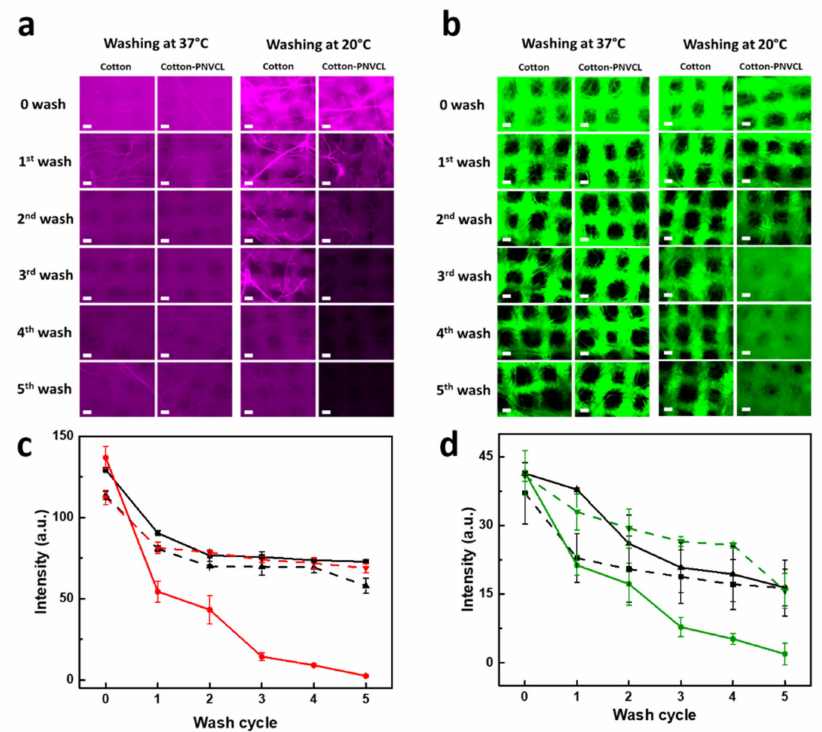
Figure 6. Fluorescence micrographs of ( a ) streptavidin-Cy5 and ( b ) green fluorescent protein (GFP) immobilized on cotton and cotton-PNVCL, recorded after washing 0, 1, 2, 3, 4, and 5 times at 37 and 20 ◦ C; scale bars: 100 µ m. ( c , d ) Fluorescence intensities of ( c ) streptavidin-Cy5 and ( d ) GFP on cotton (black lines) and cotton-PNVCL (red / green lines) plotted with respect to the number of wash cycles at 37 ◦ C (dashed lines) and 20 ◦ C (solid lines).